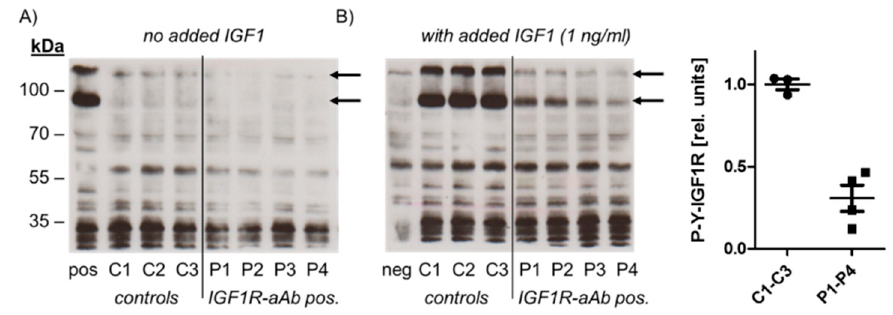
Figure 3. Molecular analysis of the biological activity of the IGF1R-aAb. Immunoglobulins were isolated from IGF1R-aAb negative (controls, C1–C3) and the four most positive (P1–P4) serum samples, respectively, along with an IGF1-stimulated (pos) and non-stimulated negative control (neg) sample. Cell homogenates were analyzed by Western blot for receptor activation using antibodies against Tyr-phosphorylated IGF1R (P-Y-IGF1R). ( A ) In the absence of the added ligand IGF1, autophosphorylation was at basal level irrespective of the added immunoglobulins. ( B ) IGF1R autophosphorylation was induced in the presence of added IGF1 in cells co-incubated with immunoglobulins from control sera, but only faint signals were detected from IGF1-stimulated cells in the presence of immunoglobulins from IGF1R-aAb positive sera. The arrows indicate the two major bands of phosphorylated IGF1R in HepG2 cells, and the graphic depicts the band intensities of P-Y-IGF1R after IGF1 stimulation.